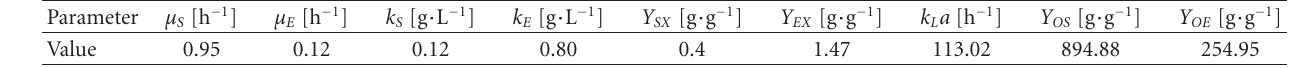
Table 5: Values of model parameters when SGA-MCS has been